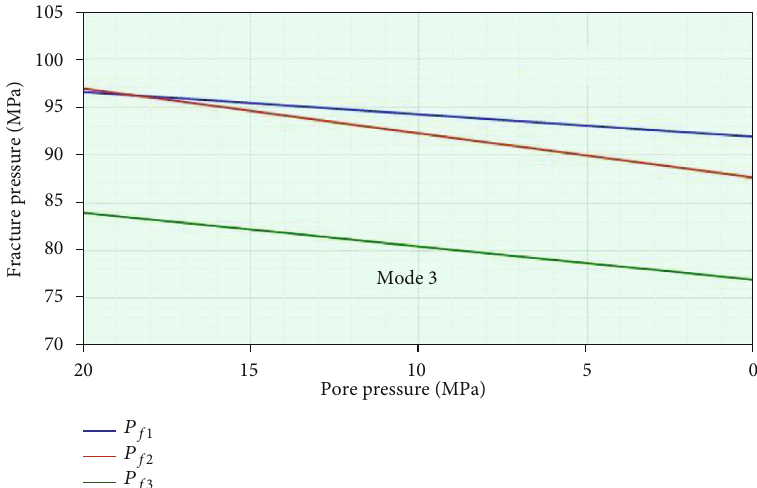
Figure 3: Change of fracture mode and fracture pressure with reservoir depletion of vertical wellbore drilled in reverse fault stress